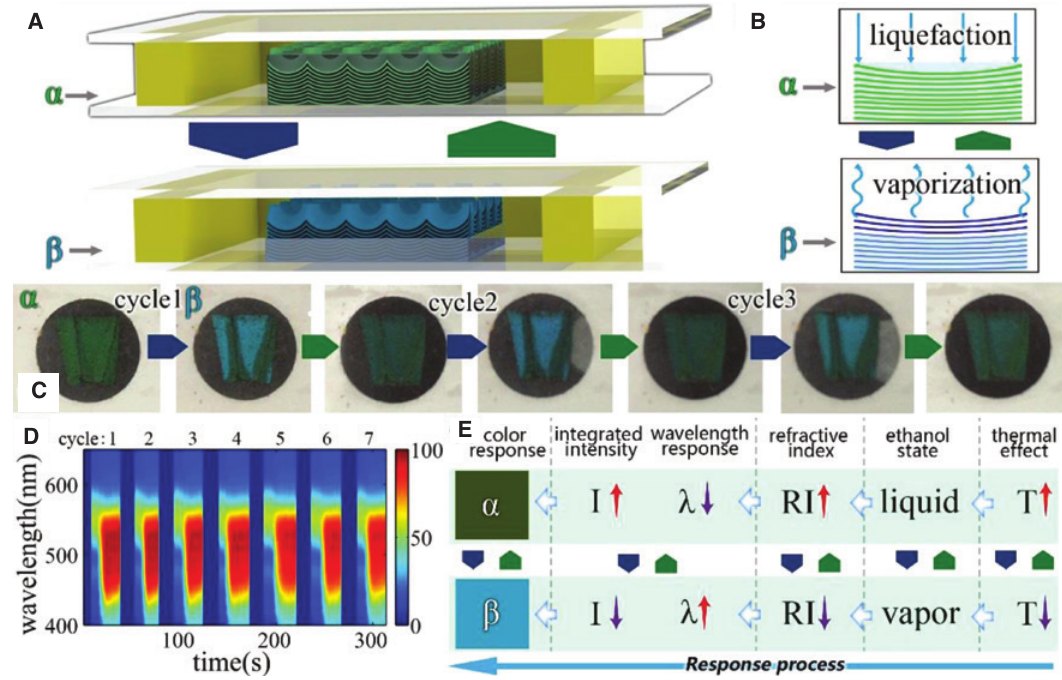
Figure 5: Reversibility of the thermochromic at multiple cyclings of the temperature. (A) The diagram of reversibility with α and β state (3D model), α : ethanol liquefaction, β : ethanol vaporization. (B) The diagram of reversibility with α and β states (2D model). (C) The digital photo of the sample at multiple cyclings of α and β states. (D) Dynamic response of LEF-PC sample in the visible spectral range. (E) Response process: thermal effect, ethanol state, refractive index, wavelength and intensity response, color response. The red and purple arrows mean the increase and decrease of the